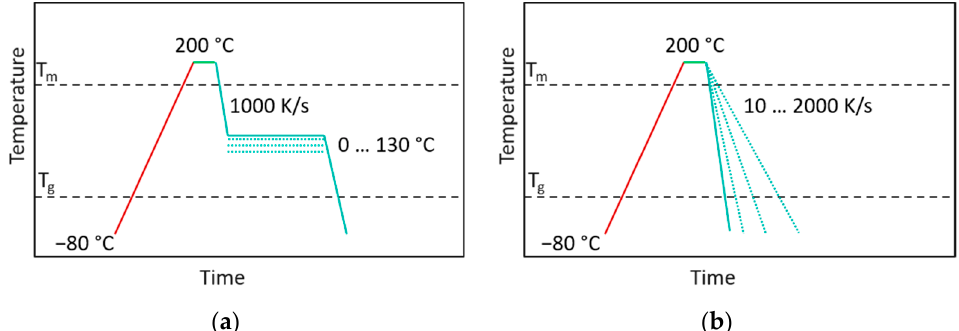
Figure 1. Scheme of the used method for isothermal ( a ) and non-isothermal ( b ) fast scanning chip calorimetry (FSC) measurement. calorimetry (FSC)